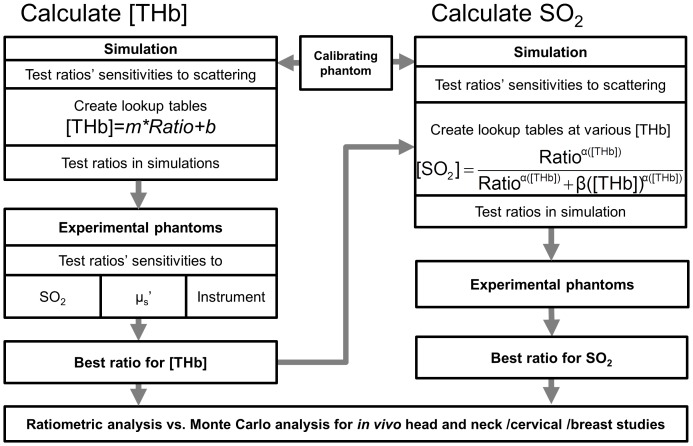
Flow chart illustrating the ratiometric analysis for [THb] and SO2 estimation.